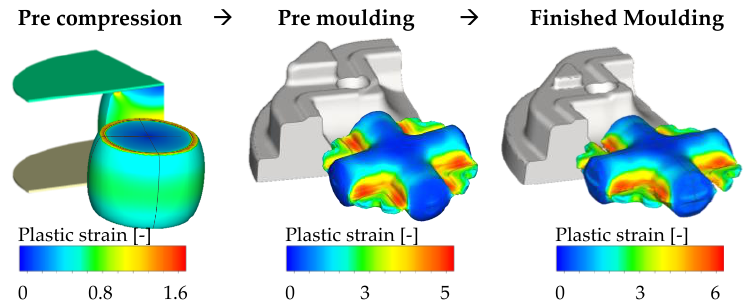
Figure 7. Three stage crosslink forming process at Hammerwerk Fridingen GmbH.